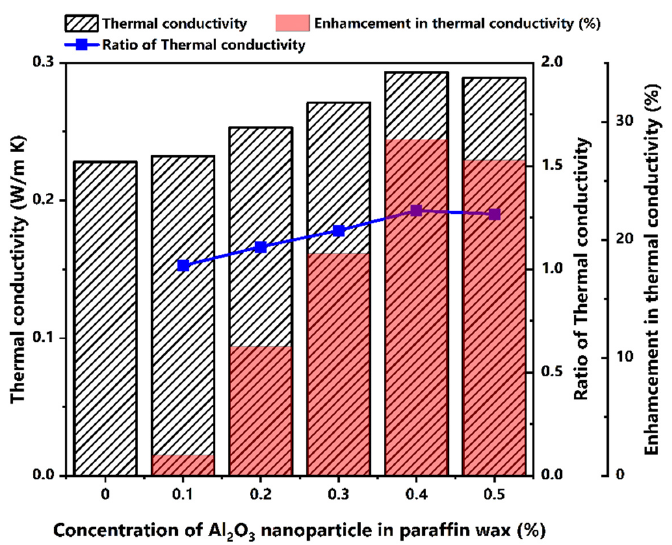
Figure 2. ( a ) SEM image of Al 2 O 3 nanoparticles. ( b ) XRD pattern of Al 2 O 3 nanoparticles. ( c ) EDS spectrum of the nanoparticles.